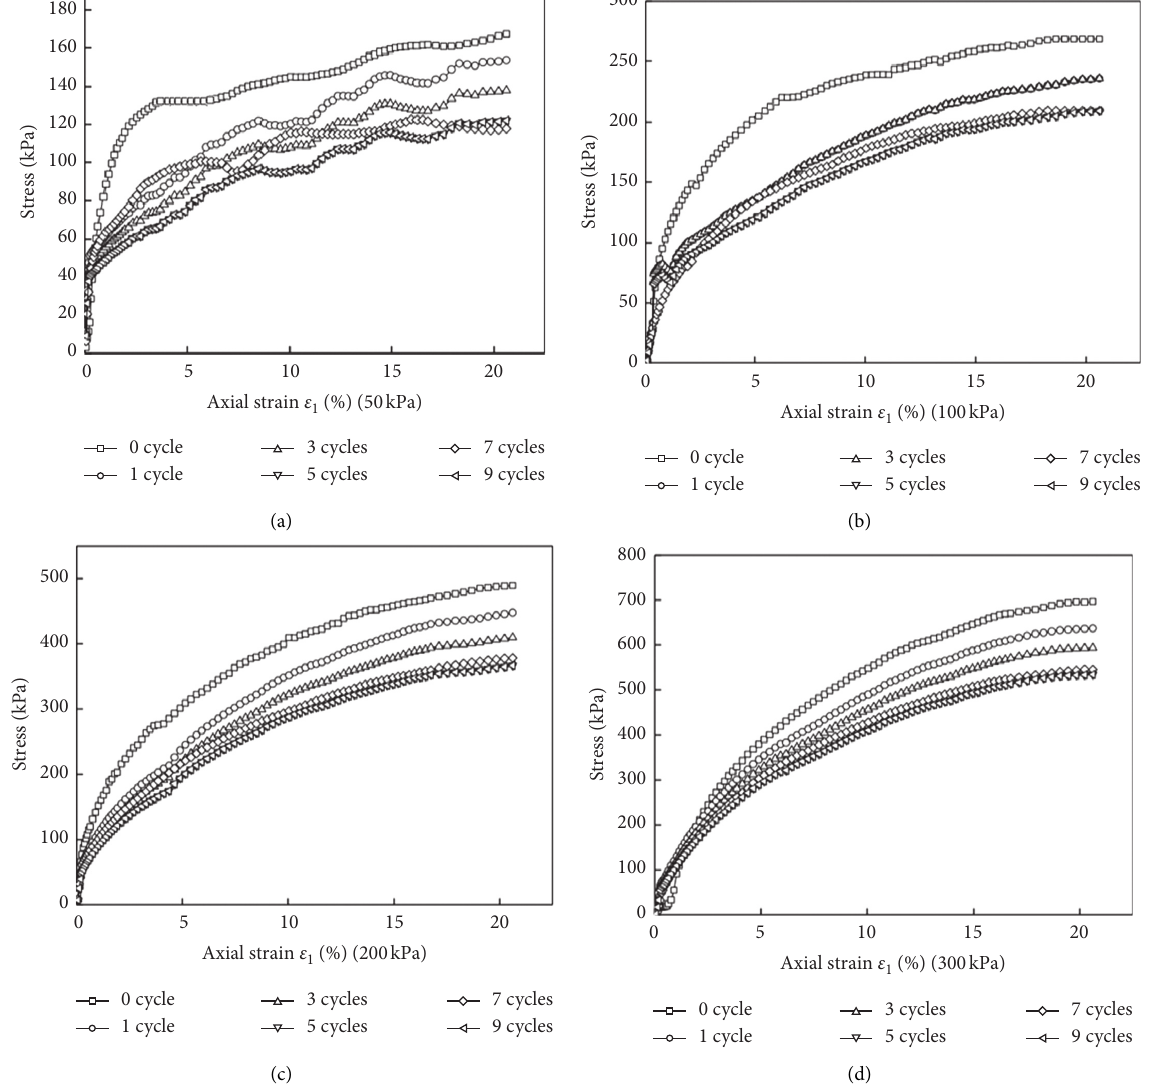
Figure 13: Deviatoric stress curve of dry and wet red clay under same confining